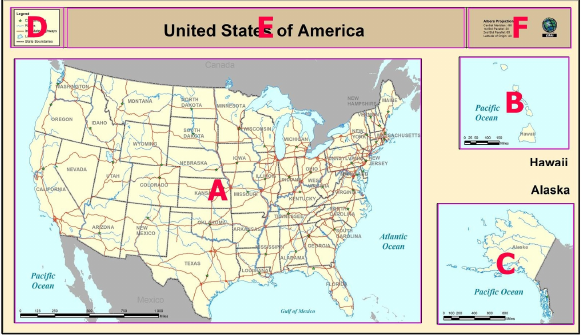
Figure 8. Areas of Interest marked in the stimulus with Map composition #1